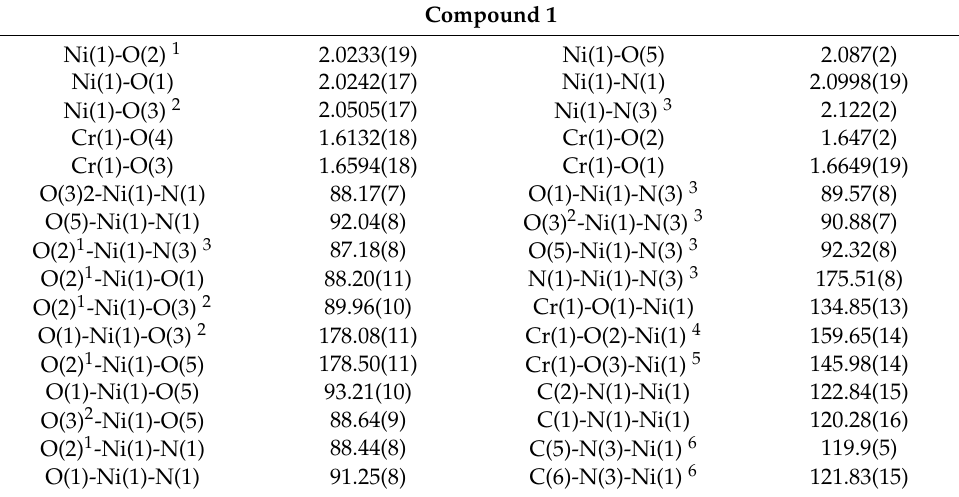
Table 2. Selected bond distances (Å) and angles ( ◦ ) for compounds 1